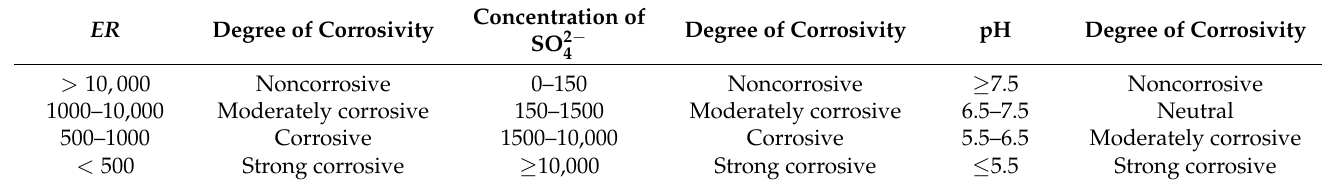
and pH) and corrosivity degree, data from [48]. 4